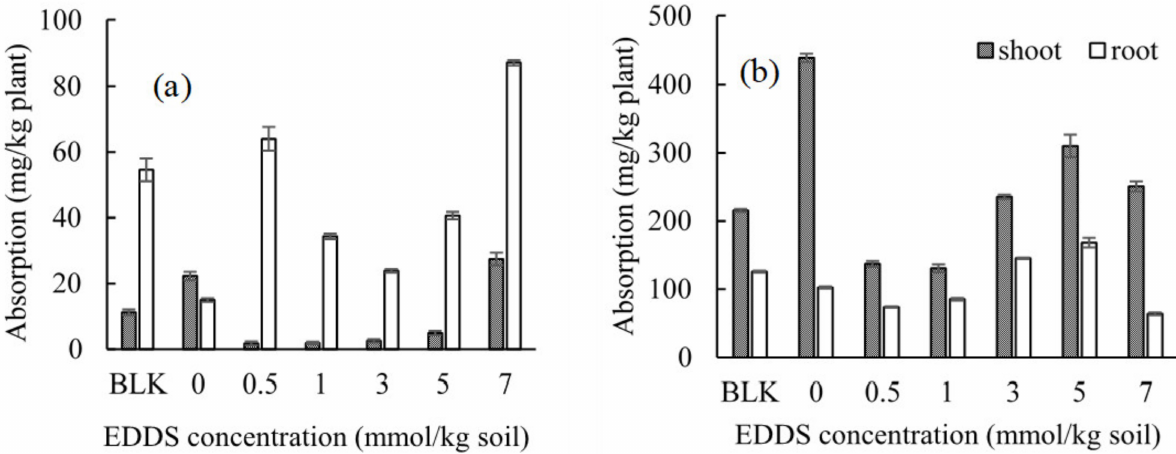
Figure 9. Effect of the EDDS concentration on the absorption of ( a ) Cd and ( b ) Zn in Gazania under the presence of Al, Bi, Ni, and Pb. BLK represents the pot for no addition of heavy metals (i.e., Al, Pb, Bi, and Ni) as well as no addition of EDDS (i.e., Pot No. 1 in Table